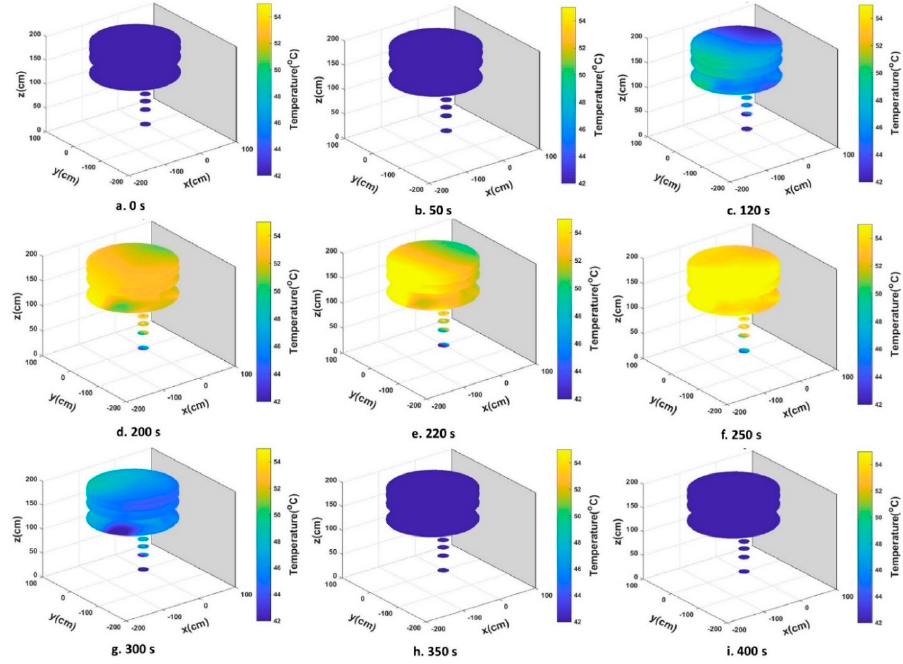
Figure 4. 3D graph of temperature distribution during heat treatment of diseased tree through the pre-treatment ( a ), treatment ( b – g ) and post treatment ( h and i ) (Repetition 1.2) .